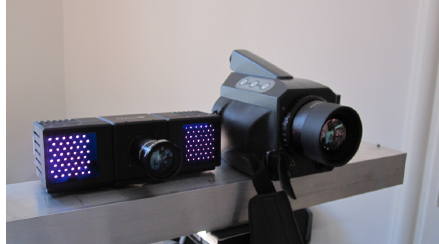
Figure 5: Sensor configuration: PMD[vision] CamCube 2.0 (left) and InfraTec VarioCAM hr (right).